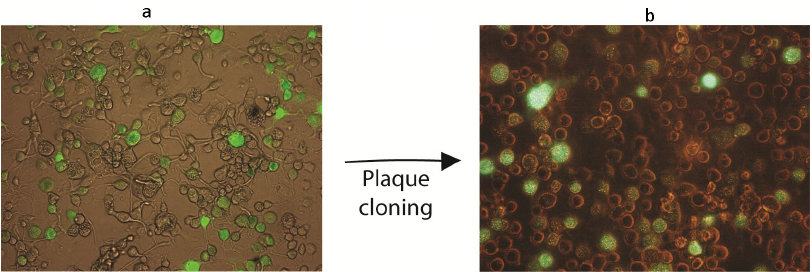
Figure 3. Generation of AgMNPV-GFP. ( a ) GFP (green fluorescent protein) expression in High Five™ cells co-transfected with linearized AgMNPV-I - P po I and pI3-GFP (schematic in Figure 4a); ( b ) High Five™ cells infected with cloned AgMNPV-GFP. Cells were infected with recombinant virus recovered from the plug of the agarose overlay from a single selected plaque. The differences in the levels of GFP expression of individual cells are related to the low multiplicity of infection.